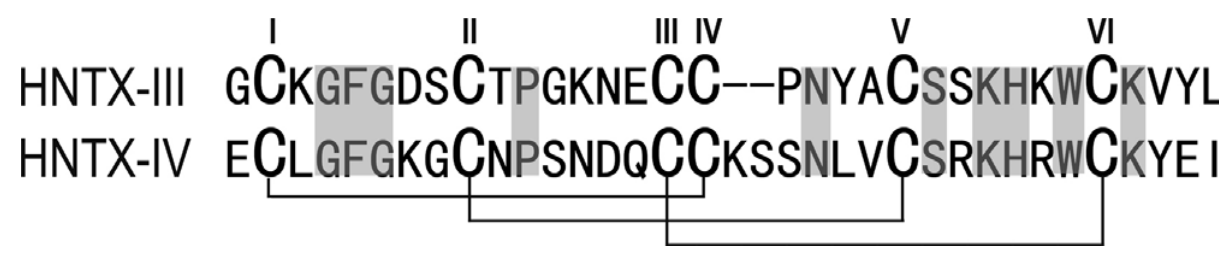
Figure 4. Deduced disulfide linkage pattern of HNTX-III and